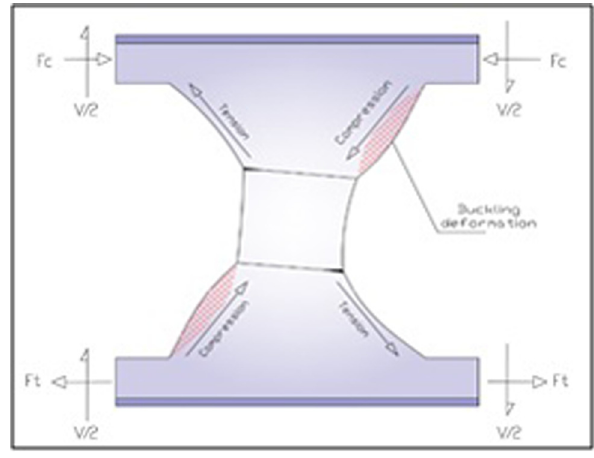
Figure 14: Web - post buckling due to shear force.